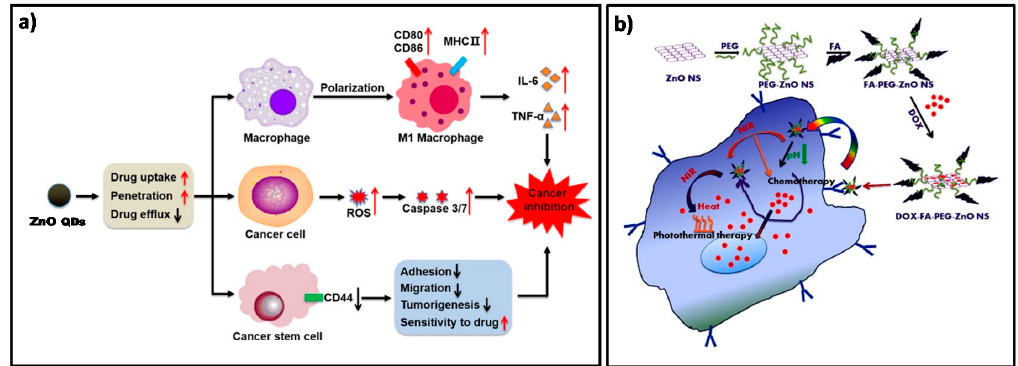
Figure 2. ( a ) Scheme of the multiple proposed effects of ZnO QDs as a multi-functional antitumour treatment. Reproduced with permission from [44]. American Chemical Society, 2017. ( b ) Scheme of the combined mechanism of action of DOX-FA-ZnO NS for breast carcinoma therapy. Reproduced with permission from [48]. Elsevier, 2017.